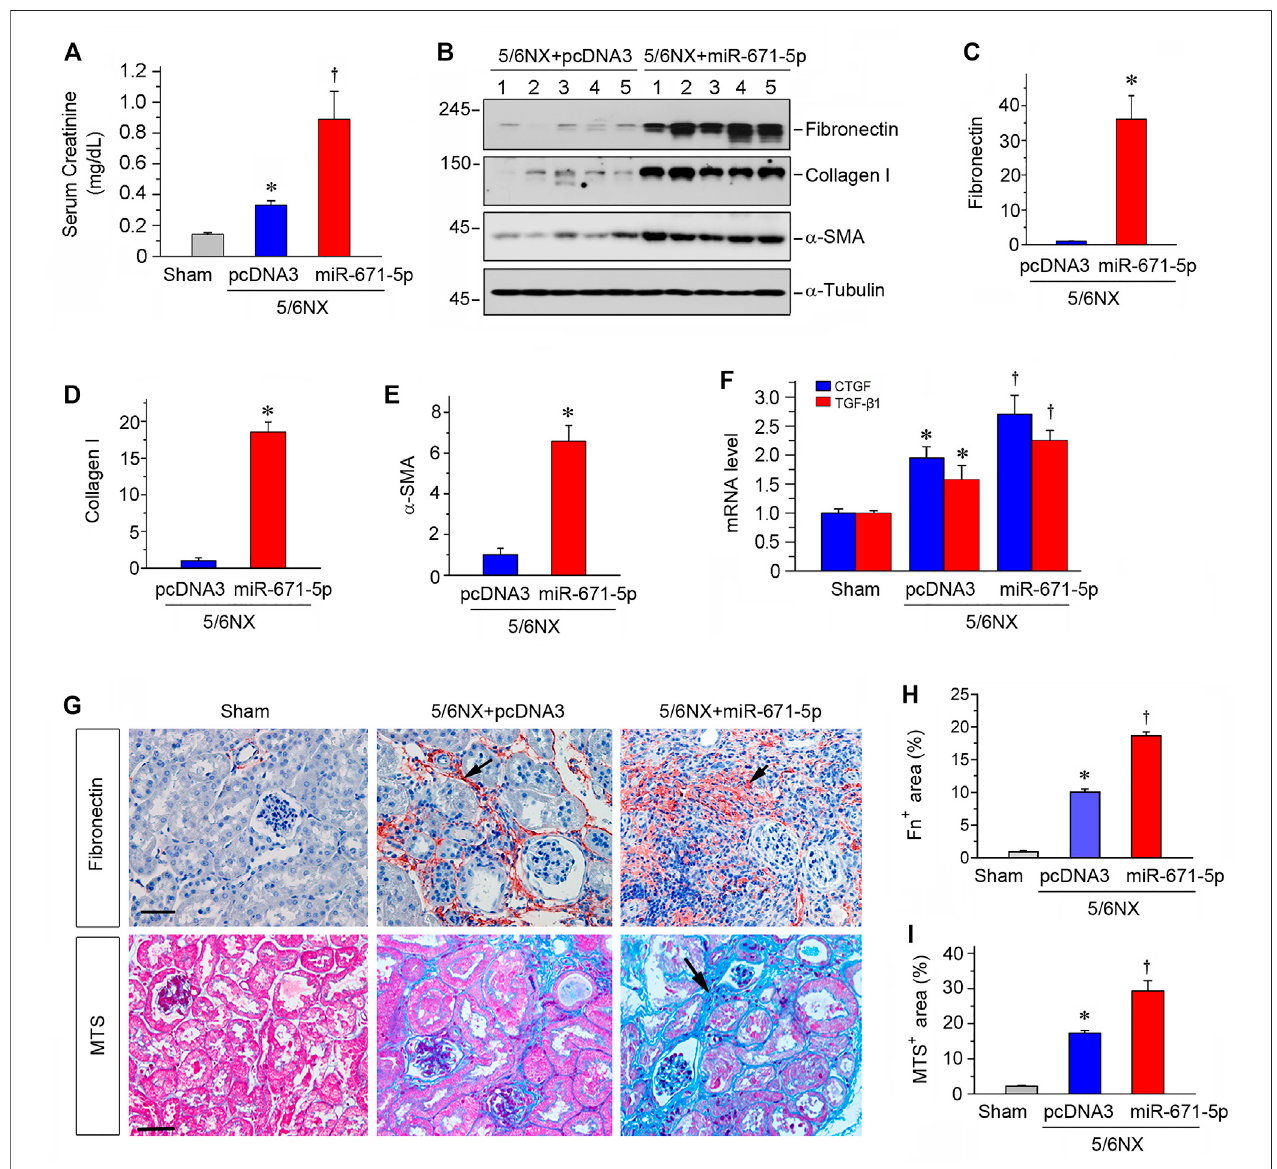
FIGURE 5 | Expression of miR-671-5p in vivo aggravates kidney dysfunction and fi brosis in 5/6NX model. (A) Expression of miR-671-5p in vivo aggravates kidney dysfunction in 5/6NX mice. Serum creatinine was assessed in different groups as indicated. * p < 0.05 versus sham controls, † p < 0.05 versus 5/6NX ( n (cid:1) 5 – 6). (B – E) Representative Western blots (B) and graphic presentations of fi bronectin (C) , collagen I (D) and α -SMA (E) were presented. * p < 0.05 ( n (cid:1) 5 – 6). (F) qRT-PCR analysis shows CTGF and TGF- β 1 mRNA levels in different groups. * p < 0.05 versus sham controls, † p < 0.05 versus 5/6NX ( n (cid:1) 5 – 6). (G) Representative micrographs show that overexpression of miR-671-5p aggravated fi bronectin deposition and fi brotic lesions in the 5/6NX kidneys. Paraf fi n kidney sections were stained for fi bronectin (upper panel) and subjected to Masson ’ s trichrome staining (MTS) (bottom panel). Scale bar, 50 µm. (H,I) Quantitative determination of renal fi bronectin expression (H) and renal collagen deposition (based on MTS) (I) in different groups. * p < 0.05 versus sham controls, † p < 0.05 versus 5/6NX ( n (cid:1) 4 – 6).